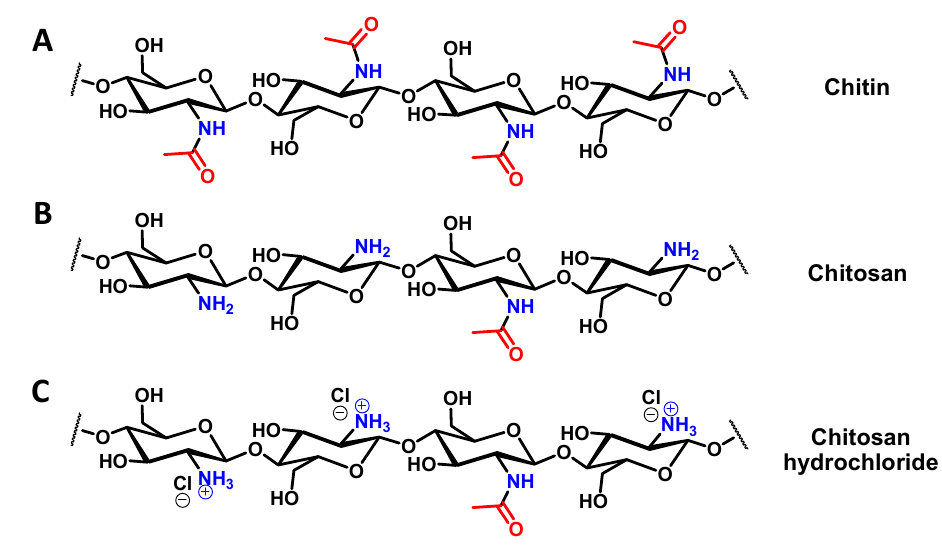
Figure 2. Chemical structures of the formed molecules. ( A ) Chemical structure of chitin; ( B ) Chemical structure of chitosan; ( C ) Chemical structure of chitosan hydrochloride. 155